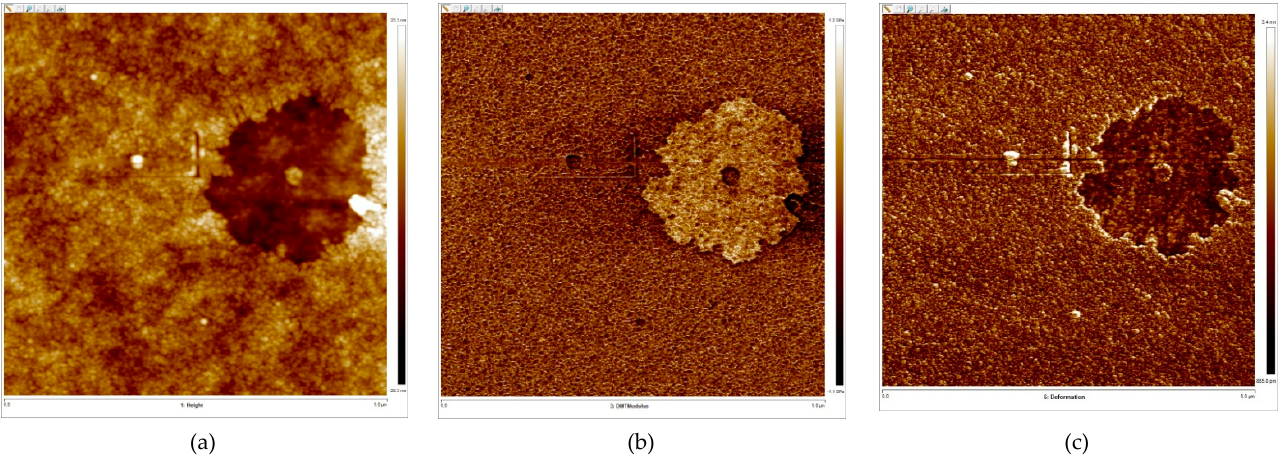
Figure 11. AFM images of the surface area of the CT100-PVP film obtained by evaporation of the solution (at a mass ratio of polymers 1:2) in topography mode ( a ), Young’s modulus ( b ) and deformation ( c ) measured in the PeakForce QNM mode.